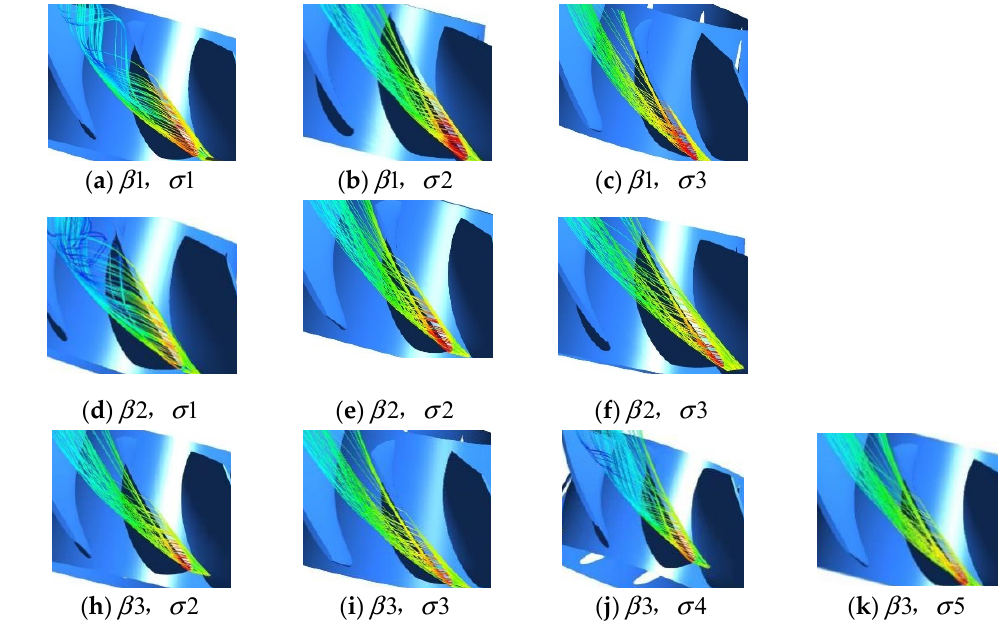
Figure 23. Velocity streamline of the rotor blade tip at different oblique angles and cavitation numbers.